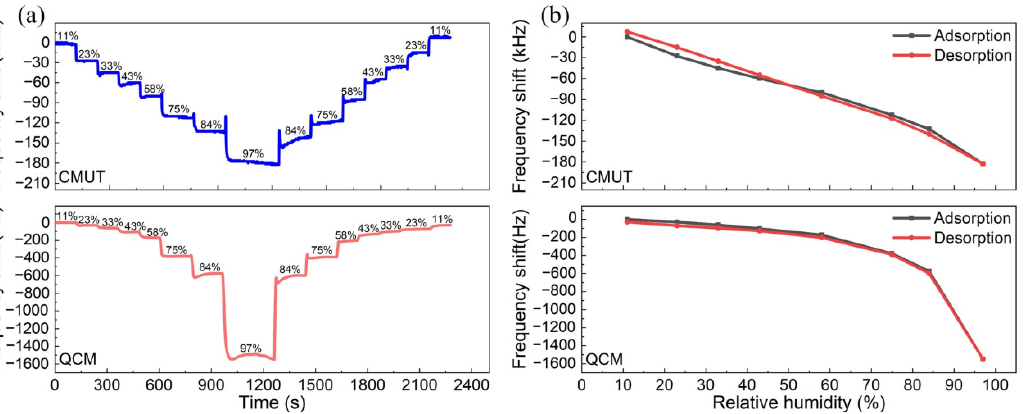
Figure 7. ( a ) Real-time frequency shift measurements of the sensors during the adsorption and desorption processes; ( b ) hysteretic curves of the sensors.